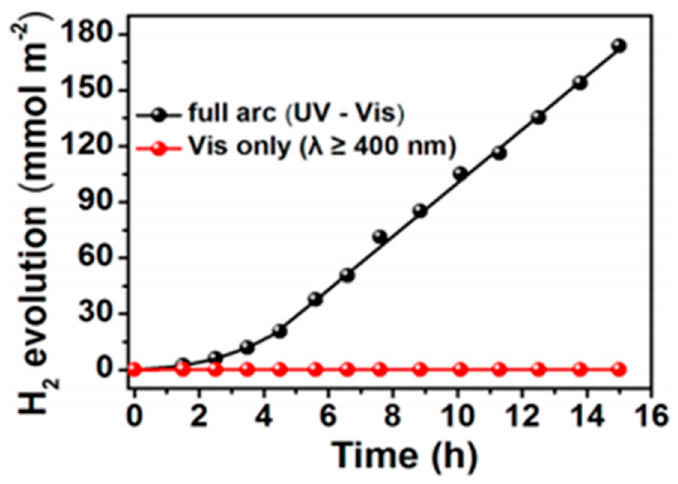
Figure 13. Time course of H 2 generation from a methanol solution with a catalyst developed by Hu et al. [10] Reprinted with permission from ref. [10].